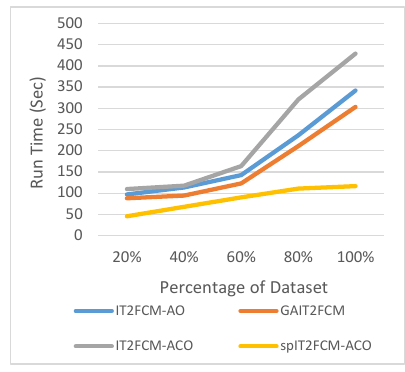
Figure 11. Analysis of run time for different percentages of KDD cup dataset.